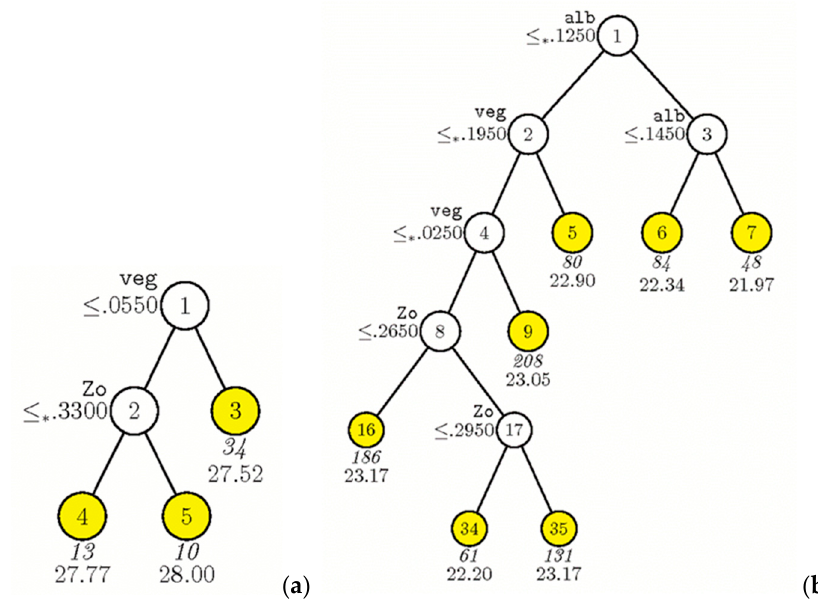
Figure 11. CART for transects ( a ) TR04 and ( b ) TR13.